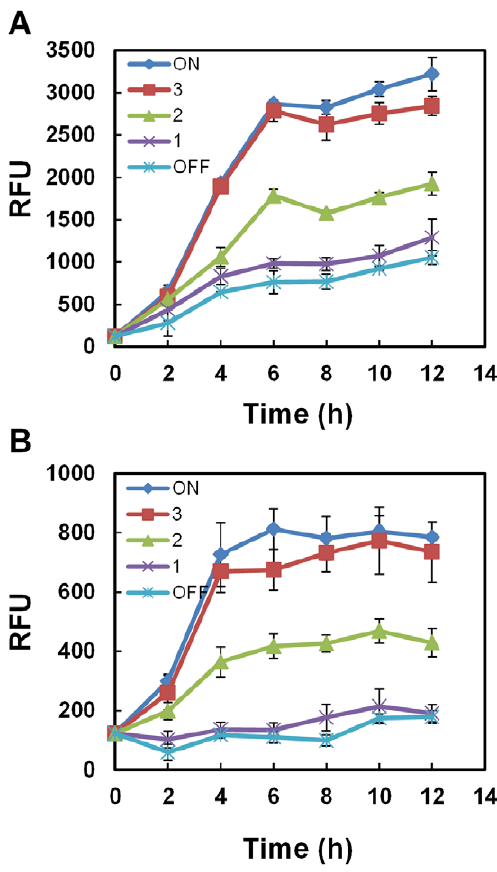
Figure 4. Turn-off control to switch the genes from the ON state to the OFF state. The cells harboring (A) pJM1 with a strong RBS (strain JM1013) or (B) pJM2 with a weak RBS (strain JM1014) were inoculated and incubated in the microplate for 2 h until the OD 600 reach approximately 0.3, and then were initially exposed to light for 1, 2, or 3 h, and then, switched to darkness until the end of the experiment. RFP fluorescence per unit of OD 600 was measured. Data are presented as mean 6 SD and basal values were not subtracted. This experiment was performed using the same culture method as described in Fig. 3.